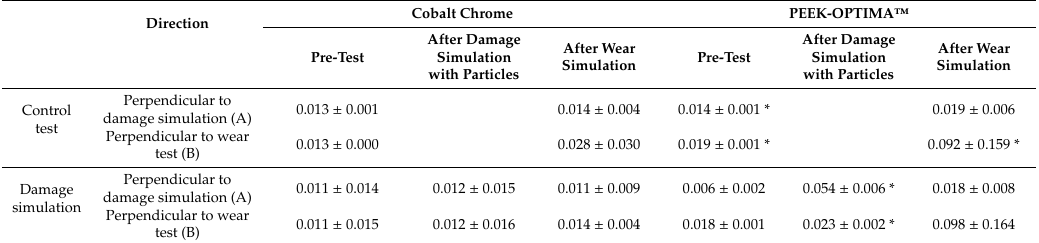
Table 1. Mean surface roughness (Ra), µ m ( ± 95% confidence limits) of cobalt chrome and PEEK plates, pre-test, after damage simulation with polymethyl methacrylate (PMMA) cement particles and after wear simulation. Measurements were taken either perpendicular to or parallel to the direction of damage simulation (N = 3). Statistical analysis to compare ultra-high molecular weight